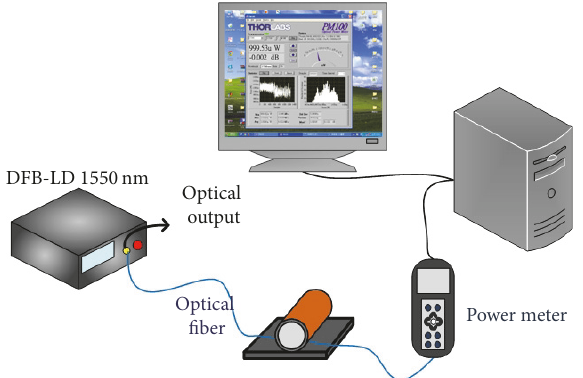
Figure 1: Schematic diagram of optical fiber polishing arrangement.